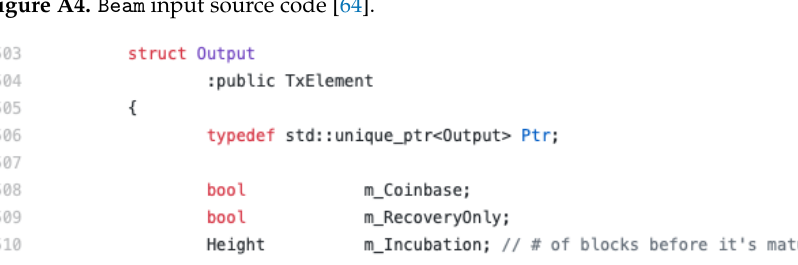
Figure A4. Beam input source code [64].